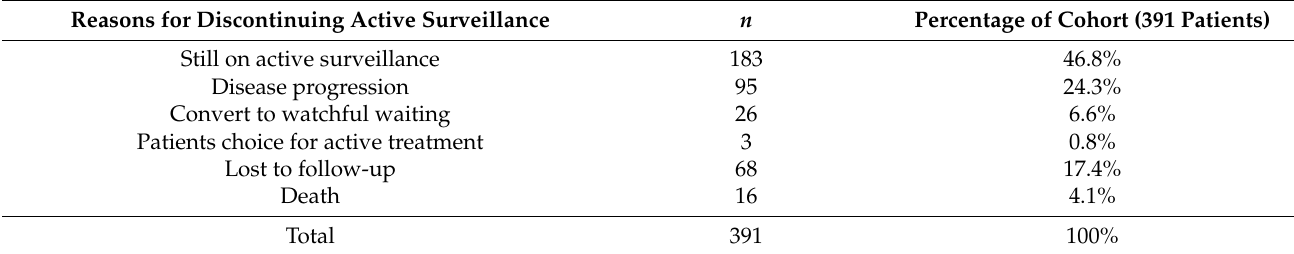
Table 3. Adherence to active surveillance.